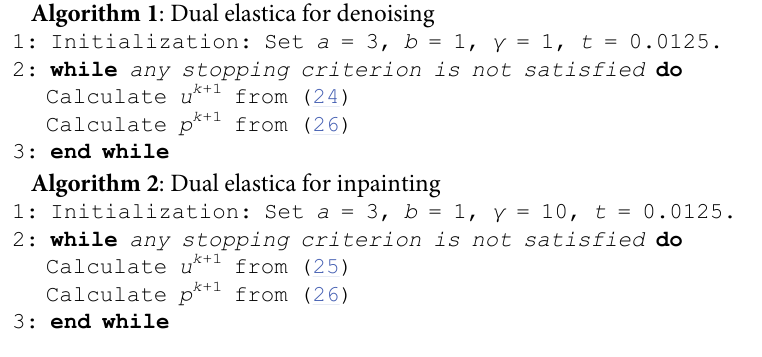
Algorithm 2 : Dual elastica for inpainting